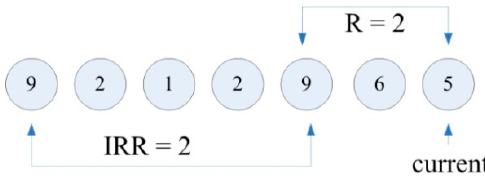
Figure 1. Example of the page parameters IRR (Inter-Reference Recency) and R (Recency).